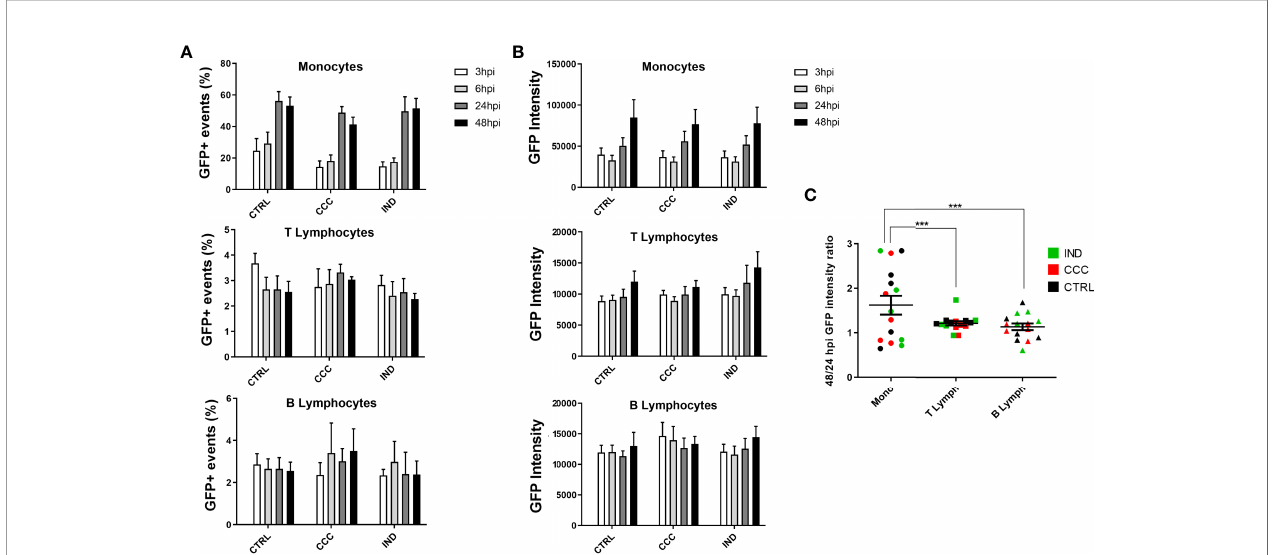
FIGURE 1 | Results from infection assay of PBMCs by fl ow cytometry with GFP-expressing Y strain. (A) The infection rate over time points was analyzed through the percentage of GFP+ events in Monocytes, T and B Lymphocytes. (B) The proliferation rate over time points was analyzed through the GFP intensity across times points in Monocytes, T and B Lymphocytes. (C) The 48/24 hpi GFP intensity ratio was used to calculate the proliferation between 24 and 48 hpi in Monocytes, T and B Lymphocytes. (n = 5 CCC; 5 IND and 5 Non-infected controls). The symbol *** means P ≤